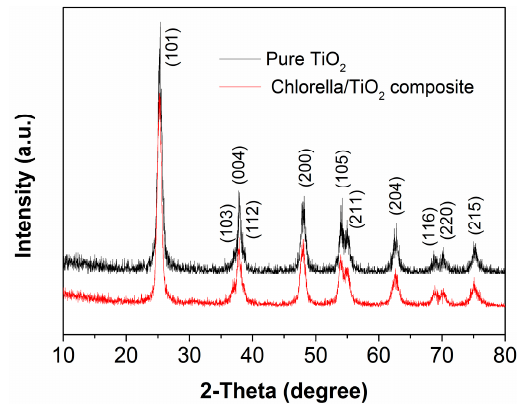
Figure 1. XRD patterns of pure TiO 2 and chlorella/TiO 2 composite.